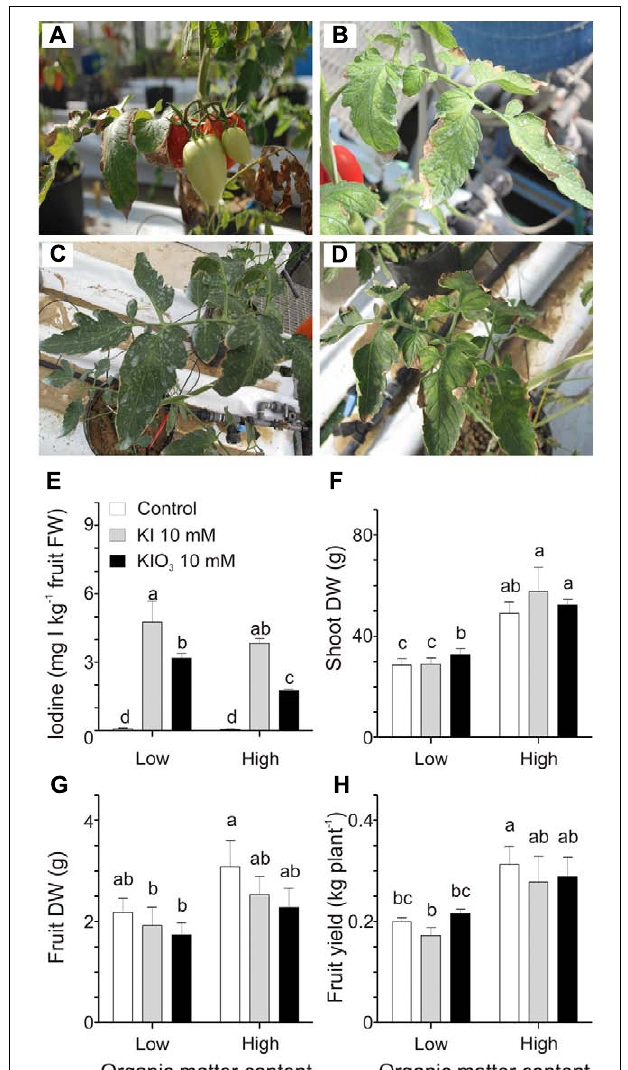
FIGURE 3 | Effect of the soil organic matter on iodine uptake and accumulation. Details of leaves and fruits from plants grown in a soil with 1% organic matter treated with 10 mM KI (A) or 10 mM KIO 3 (B) , and from plants grown in soil with 10% organic matter treated with 10 mM KI (C) or 10 mM KIO 3 (D) . Iodine levels in fruits (E) , shoot dry weight (DW) (F) , fruit DW (G) , and fruit yield (H) measured in plants grown in low and high organic matter soils and with or without a 10 mM KI or 10 mM KIO 3 treatment. Data were subjected to one-way and two-way analysis of variance (ANOVA) and the means were separated using the F -test (95.0% confidence level). Significance of two-way analysis of variance (* P -value ≤ 0.05; *** P -value ≤ 0.001; n.s. = not significant): (E) organic matter content (a): *; iodine treatment (b): ***; a x b: n.s.. (F) organic matter content